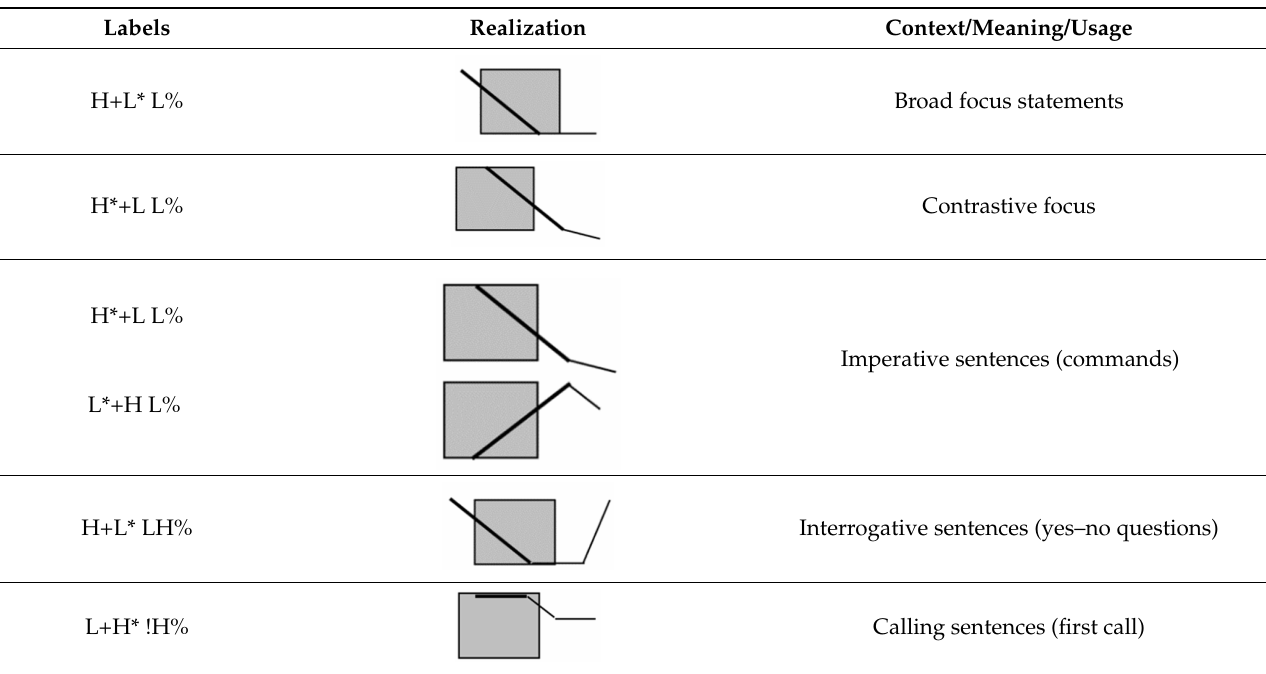
Table 2. Nuclear contours: prosodic labels following P-ToBI, phonetic realization, and context/meaning/usage. The grey box signals the stressed syllable of the nuclear word. Adapted from [12,69]. Labels Realization